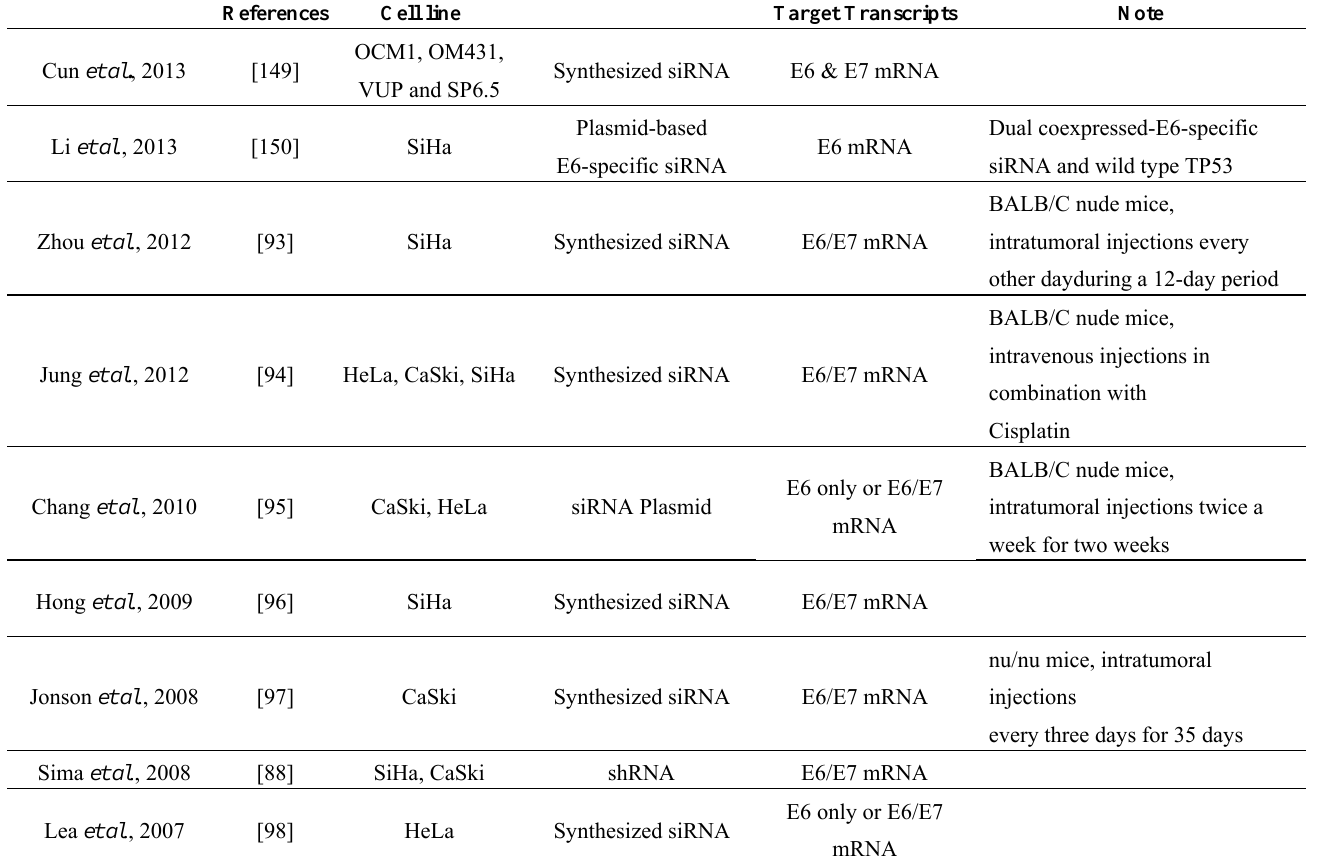
Table 2. List of RNAi studies targeting HPV E6 or